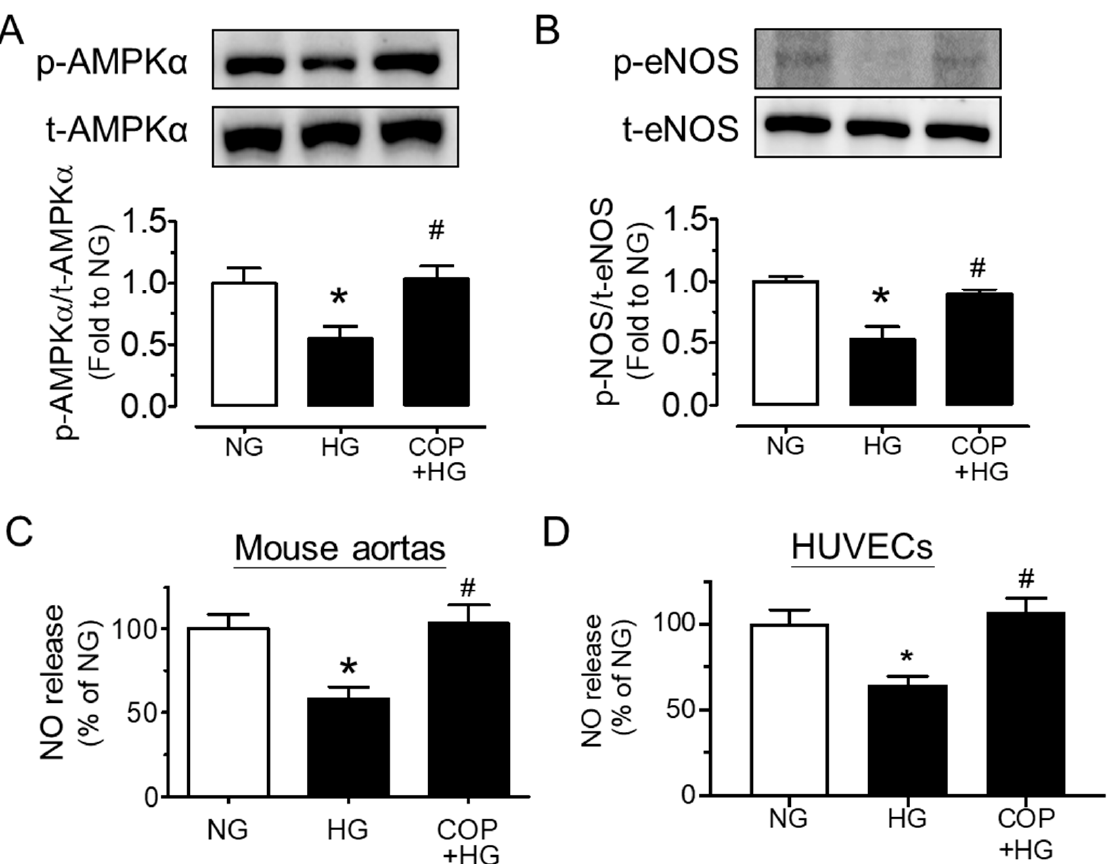
Figure 4. Coptisine (COP) stimulates AMPK/eNOS pathway and NO production. Representative blots and summarized data showing ( A ) the phosphorylation of AMPK α at Thr172 (p-AMPK α ; 62 kDa) and ( B ) phosphorylation of eNOS at Ser1177 (p-eNOS; 140 kDa) as compared to their corresponding total protein in mouse aortas treated with high glucose (HG, 30 mM) and COP (1 µ M) for 48 h. NO release from ( C ) mouse aortas and ( D ) HUVECs upon high glucose stimulation and co-treatment with COP (1 µ M) as assessed by measuring the nitrite level in culture medium. Results are the mean ± SEM of 3 experiments. * p < 0.05 vs. NG; # p < 0.05 vs. HG.